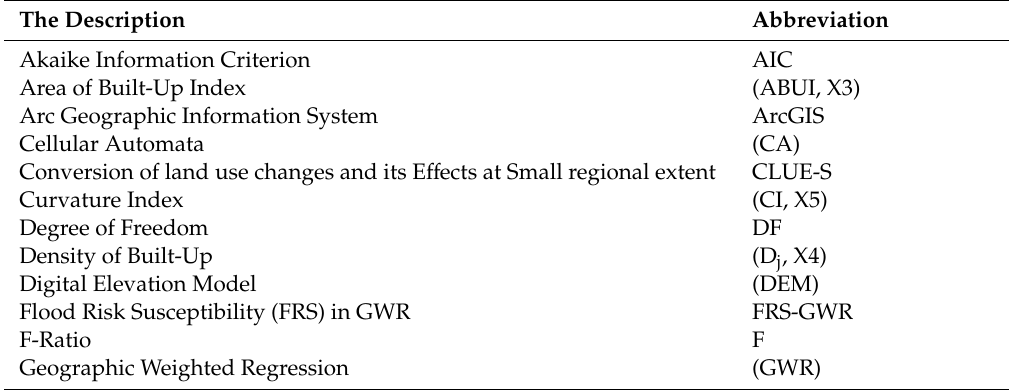
Table A12. List of